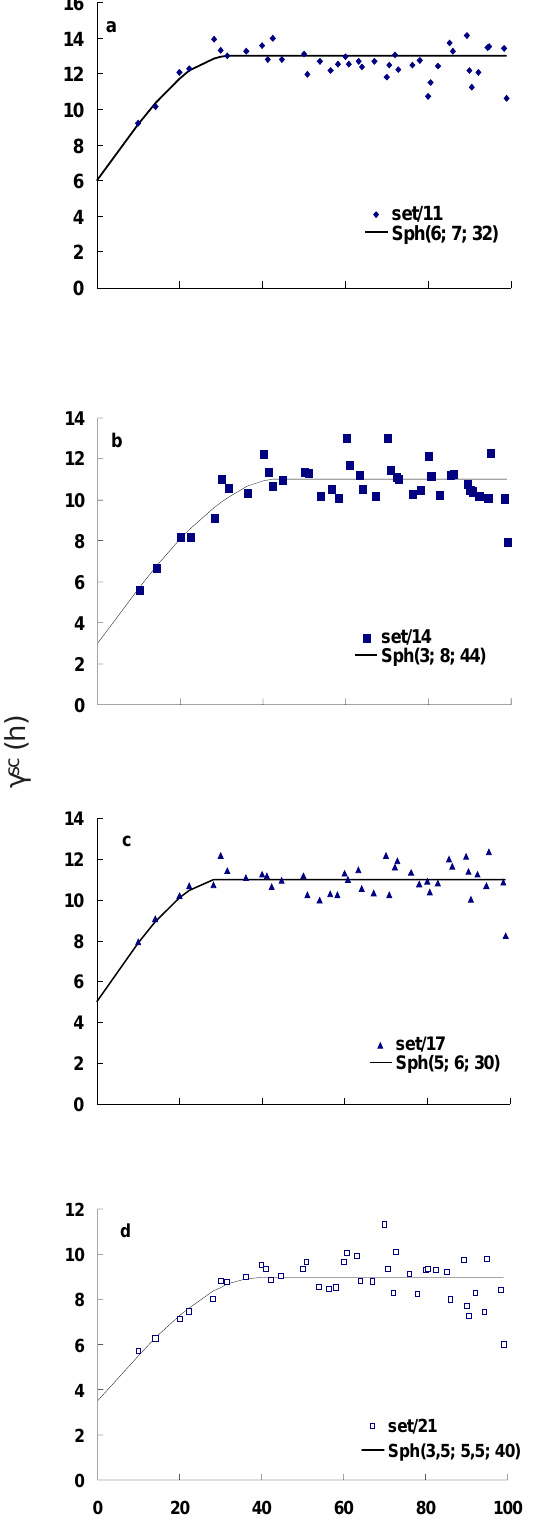
Figure 6. Individual semivariograms for soil moisture content at 0.2 m depth for the Rideau clay loam, Ottawa, Canada. In (a) Data for September/11; (b) Data for September/14; (c) Data for September/17; (d) Data for